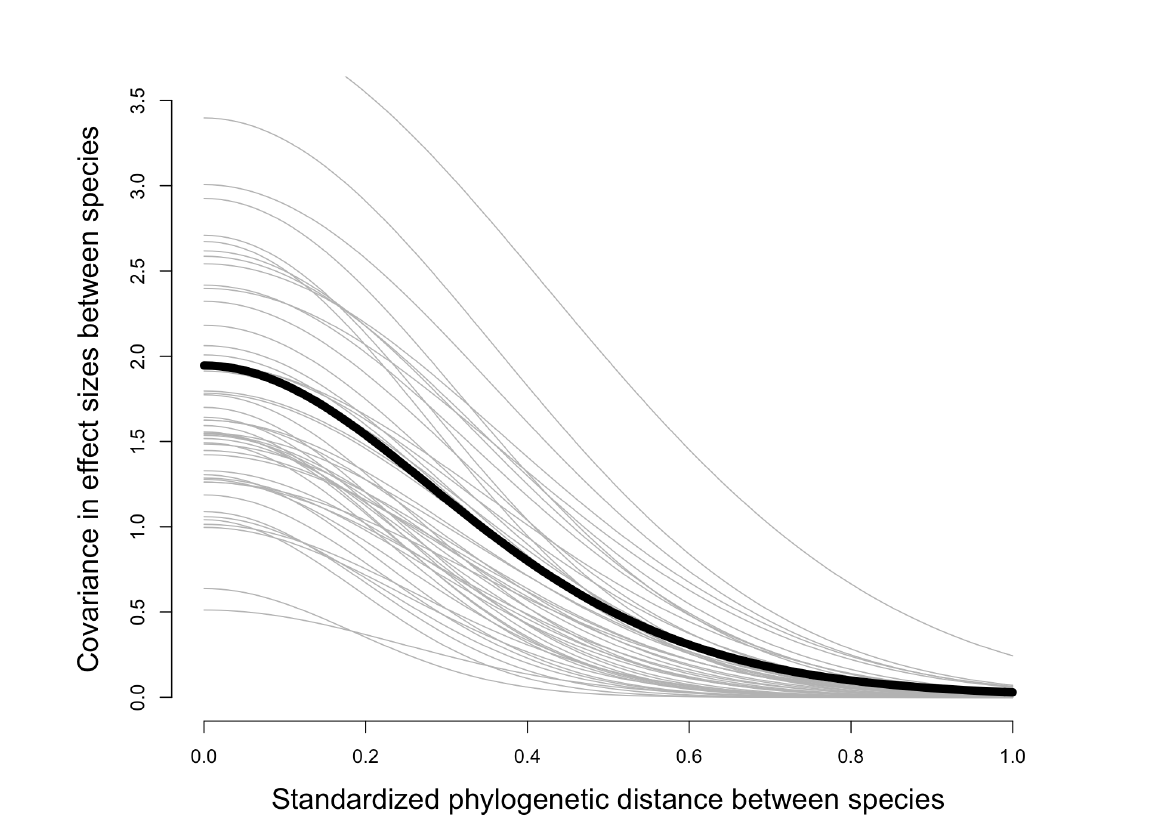
Figure 5. Relationship between the phylogenetic distance between pairs of species and the similarity of their effect sizes (solid black line represents mean estimate of rethinking model, grey lines represent variation in the estimate). Species that are closely related and share most of their phylogenetic history (standardized phylogenetic distance close to zero) show intermediate levels of covariance in their effect sizes of dominance rank on female reproductive success. The covariance drops to low values at a standardized phylogenetic distance of around 0.4, the level separating species that are part of the same